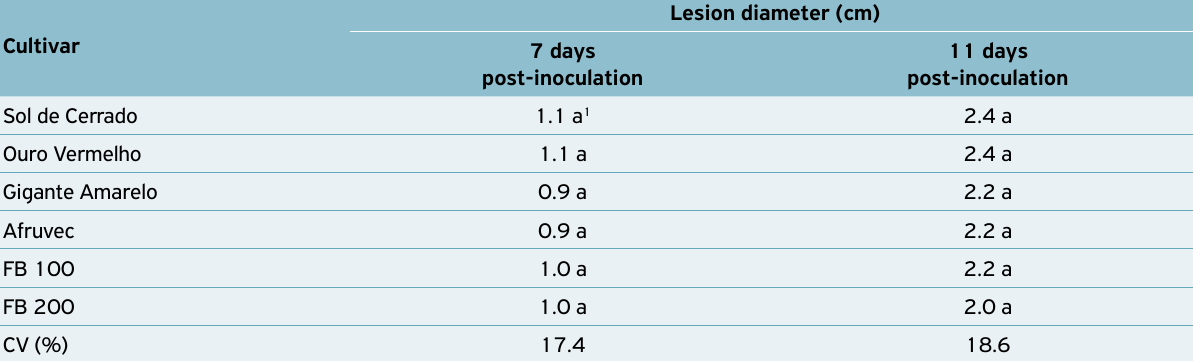
Table 1. Severity of rot caused by Ceratocystis fimbriata in cultivars of yellow passion fruit in the post-harvest. Cultivar